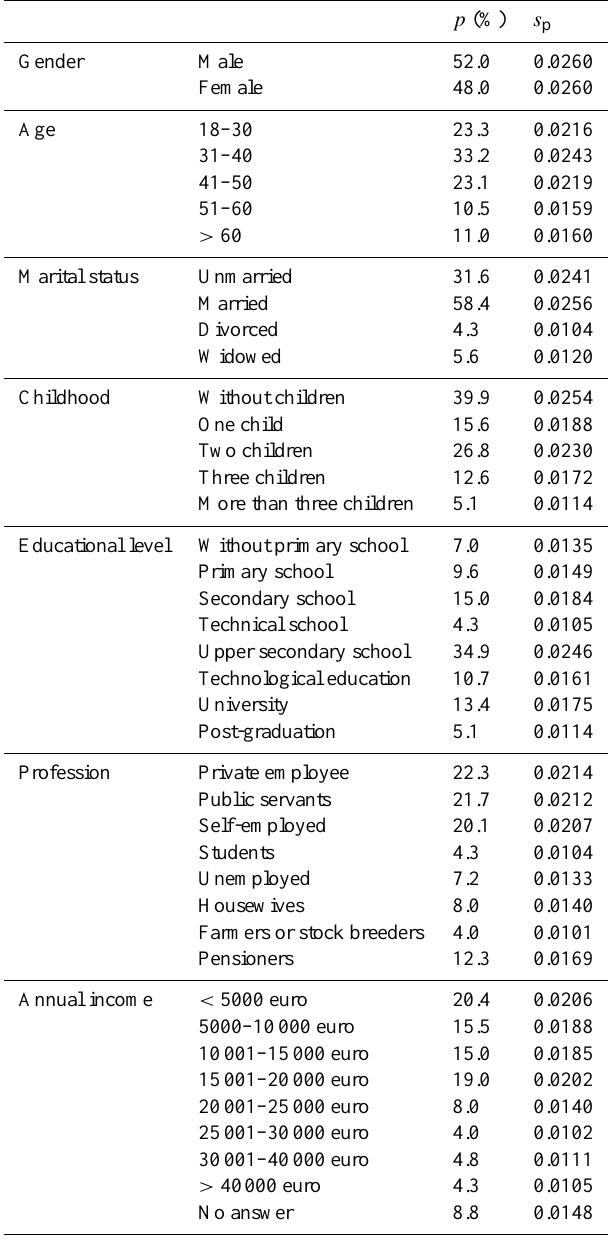
Table 1. Sociodemographic profile of the residents in the Sporades islands ( s p : Standard error of